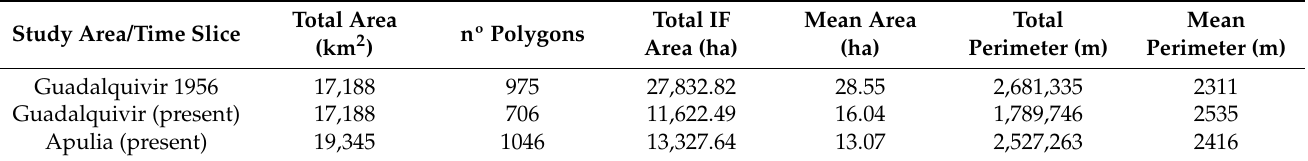
Figure 6. Present distribution of IF in the Apulia region. Table 2. Area, number of polygons, total area of Island Forests (IFs), mean area, perimeter and mean perimeter of the study